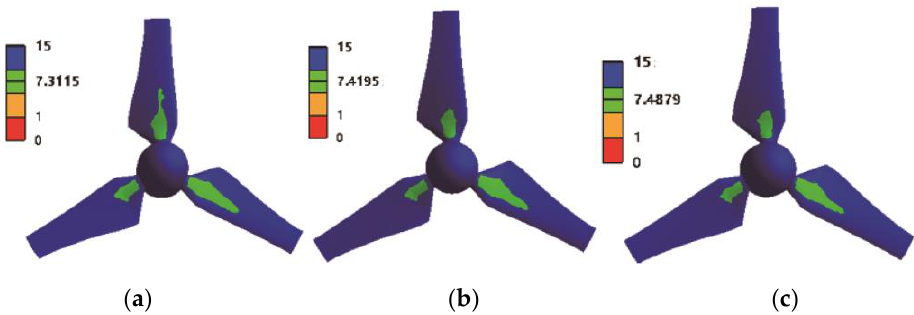
Figure 13. Blade safety factor at different water depths: ( a ) water depth of 0.48 m, ( b ) water depth of 0.6 m, and ( c ) water depth of 0.72 m.